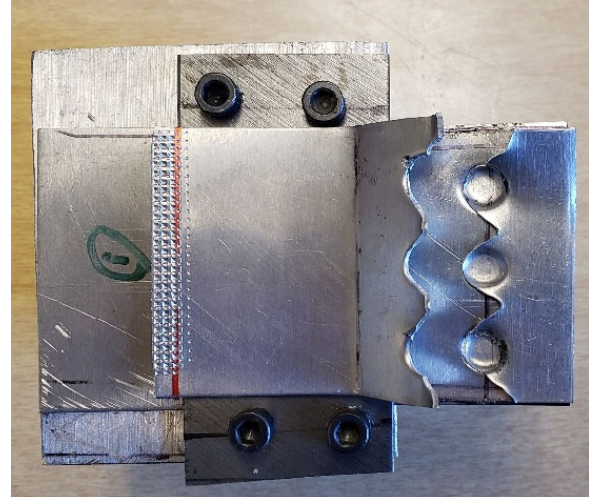
Figure 12. Failed samples obtained from the peel test.